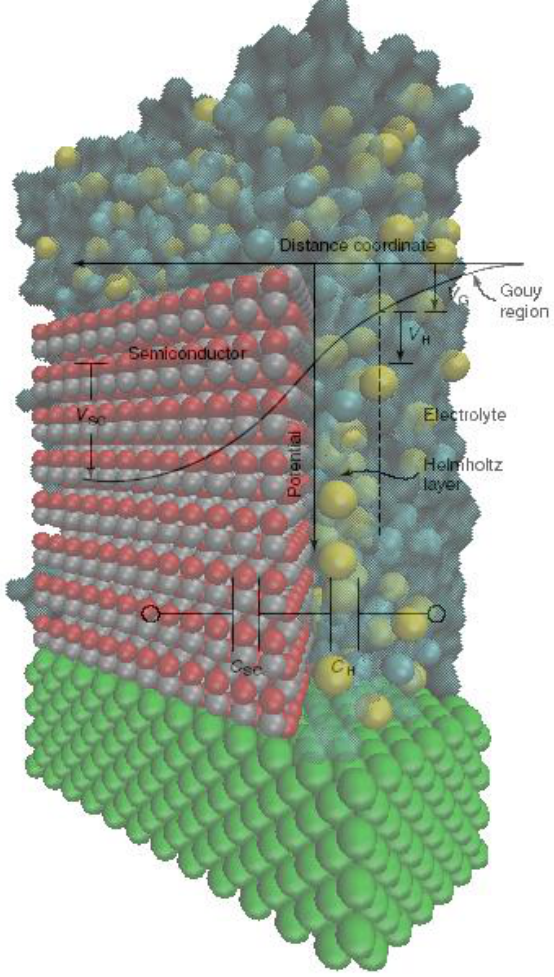
Figure 4. A simplified equivalent circuit for the semiconductor-electrolyte interface at equilibrium where the Gouy layer is